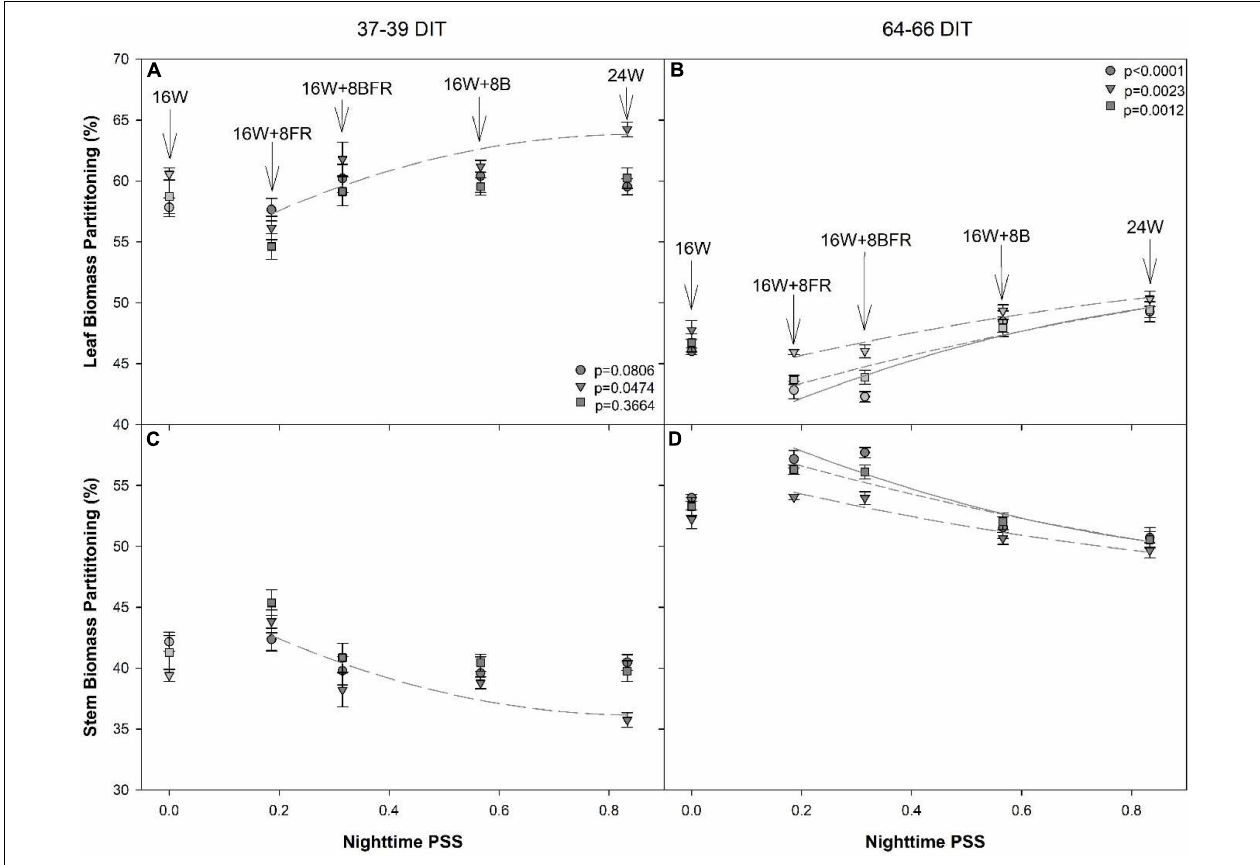
FIGURE 10 | Regression analysis of biomass partition to leaf (A,B) and stem (C,D) in dry weight from ‘Maureno’ (circle; solid line), ‘Gina’ (downward triangle; long dash line), and ‘Eurix’ (square; short dash line) during the 37–39 DIT measurements (A,C) and 64–66 DIT measurements (B,D) . Nighttime PSS of 0.833, 0.566,0.315, and 0.186 correspond to treatments 24W, 16W + 8B, 16W + 8BFR, and 16W + 8FR respectively as determined via Sager et al. (1988). Regression analysis was done using a backward elimination method. The p -values listed are for the final regressions and only regressions which were determined to be significant ( p < 0.05) are shown. The 16W treatment did not have light at night and thus was non-resultant during the PSS calculation, therefore, it was left out of the regression analysis. The biomass partition values for 16W are plotted in the graph at a PSS value of